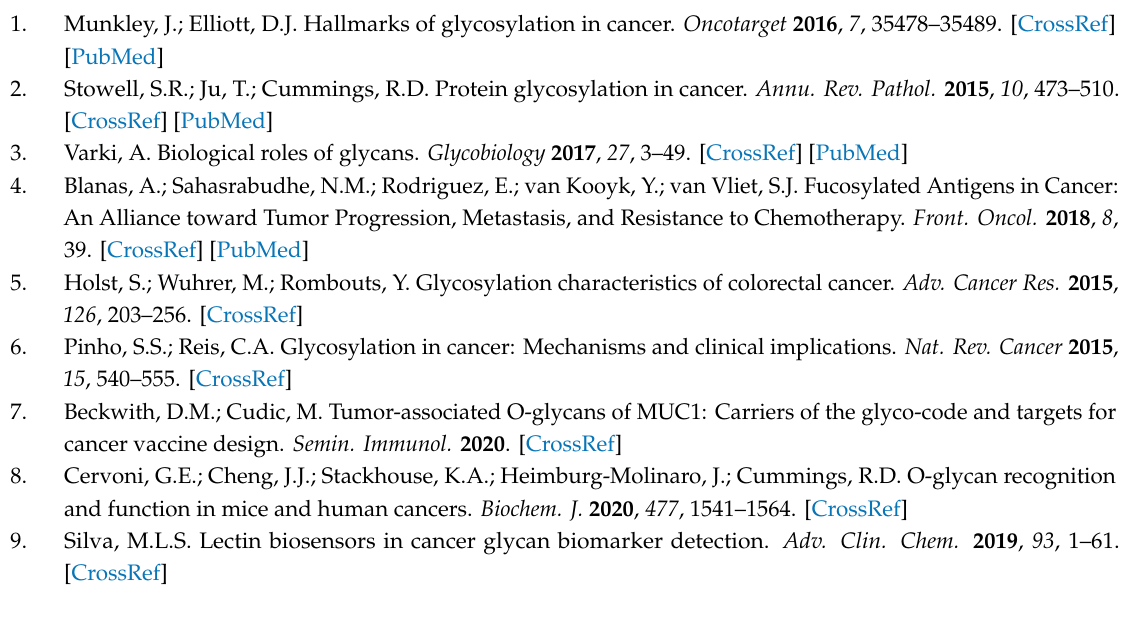
s1. Supplemental Figure S1: MGL staining of MGL-binding proteins from HCT116, HT29, and LS174T following N -glycan release. Supplemental Figure S2: c-Met levels and activation in HCT116, HT29, and LS174T. Supplemental Figure S3: Volcano plots of binary comparisons of protein abundances in the three CRC cell lines (HCT116, HT29, and LS174T) based on quantitative proteomics analysis. Supplemental Figure S4: Proteins observed at di ff erent levels in the high-MGL-binding cell lines (HT29 and HCT116) compared to the low MGL-binding cell line. Table S1: Release of N -glycans reduces the MGL-binding of proteins from CRC cell lines. Table S2: Raw data of comparative quantitative proteomics with TMT labeling on HCT116, HT29, and LS174T. The binary comparison of the protein abundance is shown. Table S3: Binary abundance ratio of the major cell surface MGL-binding proteins in HCT116 and HT29 cells compared to